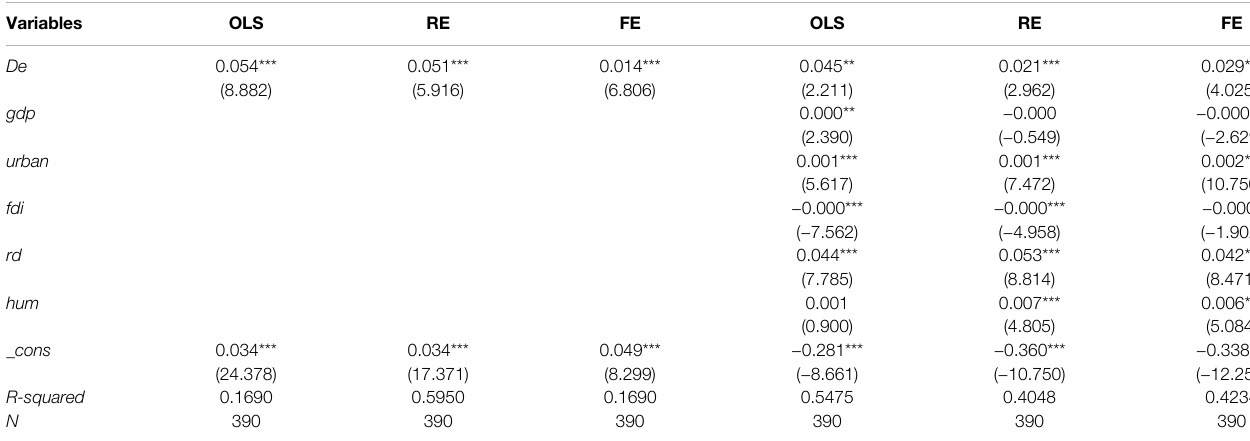
TABLE 5 | Robustness test results (removing extreme values).